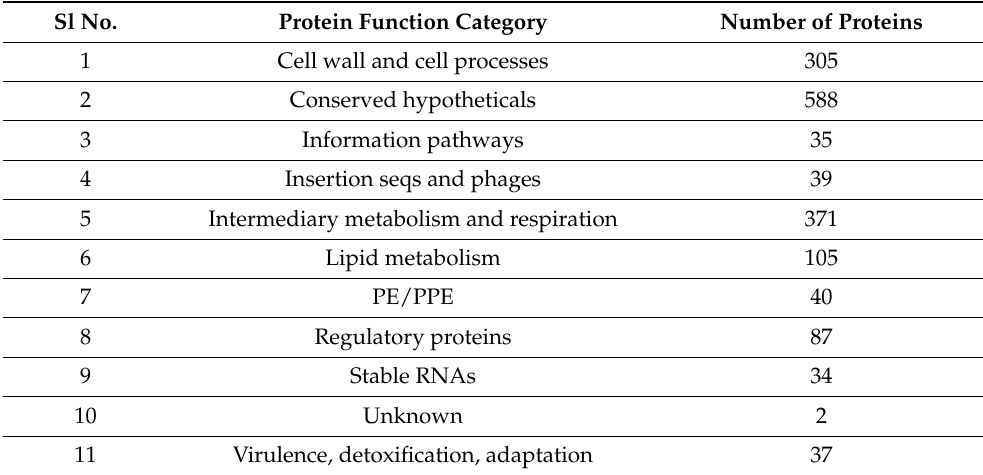
Table 3. List of functional categories and number of proteins in each category. Sl No. Protein Function Category Number of Proteins Cell wall and cell